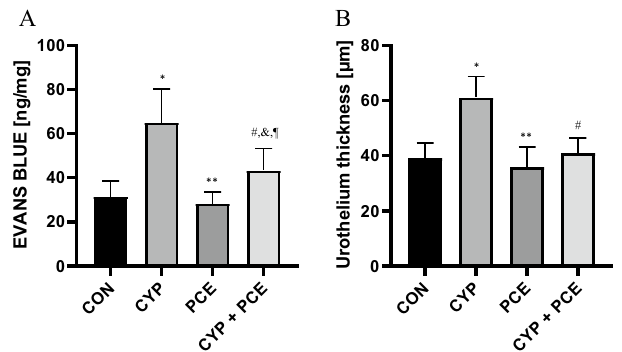
Figure 1. The influence of cyclophosphamide (CYP) and Potentilla chinensis aqueous extract (PCE) in naïve rats and PCE in rats with CYP-induced cystitis on the level of ( A ) bladder wall oedema, and ( B ) urothelium